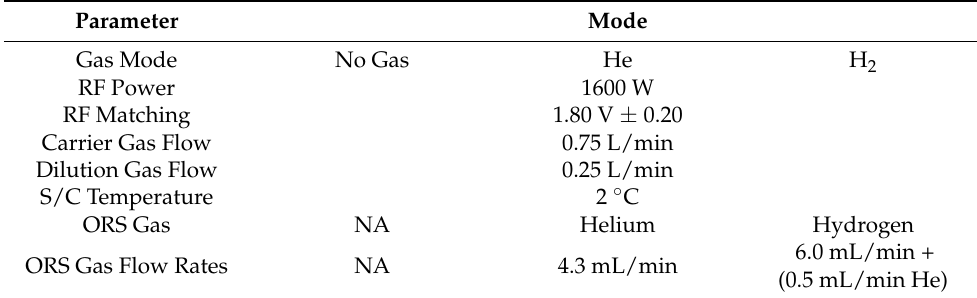
Table 3. ICP-MS operating parameters for the detection of metals.